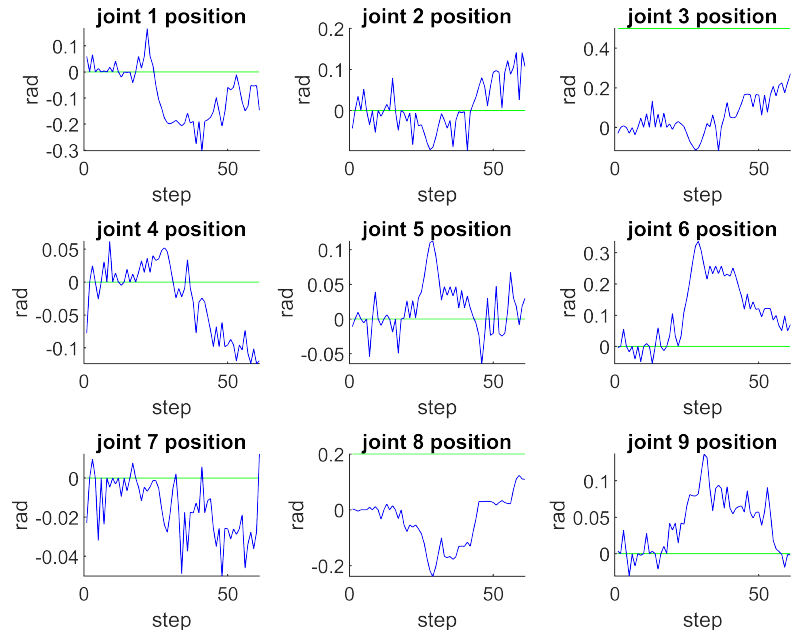
Figure 7. These joint positions correspond to reaching task 1. The larger jitters are due to exploratory behavior, which is triggered to collect more information about the robot’s local